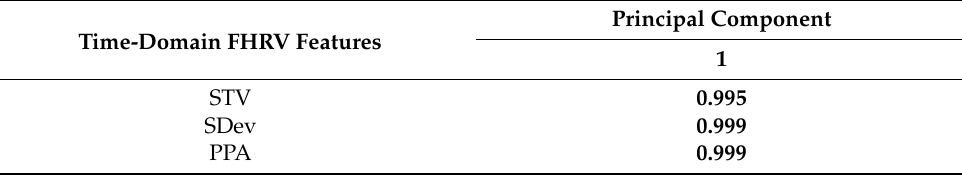
Table 1. Dimension reduction of time-domain features of the